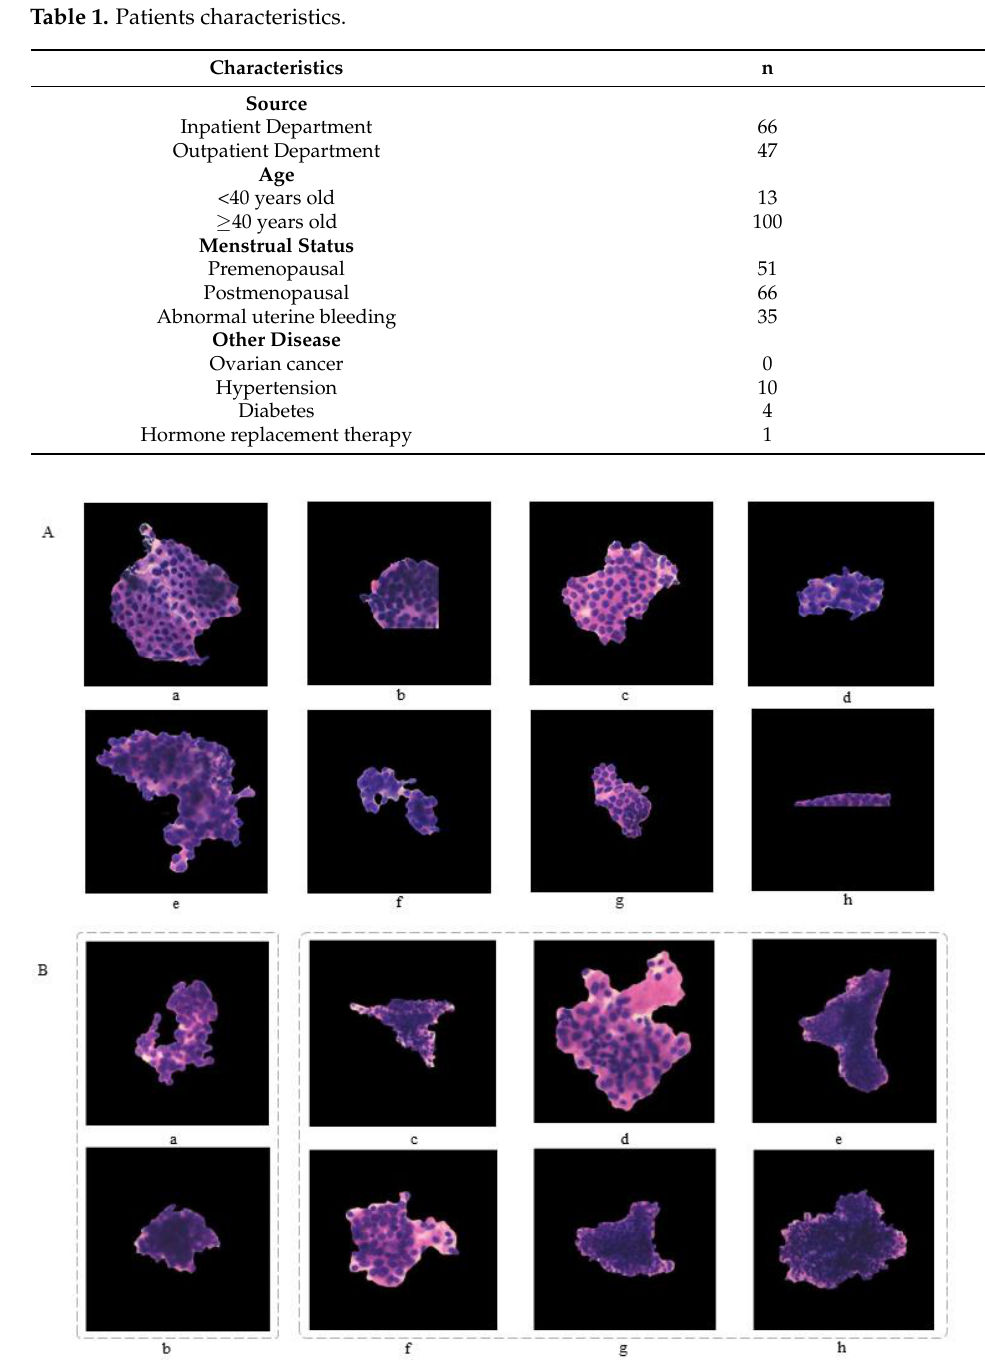
Figure 6. Presentation of true and false results. ( A ) A 100% consistency of results was achieved in the training set. Patches ( a – c ) showed the true positive, and patches ( d – h ) showed the true negative. ( B ) Analysis of false results in test set. The two false-positive (over diagnosis) patches ( a , b ) are exhibited. The six false-negative patches included one well-differentiated endometrial adenocarcinoma ( c ), three atypical hyperplasia ( d – f ), and two poorly differentiated adenocarcinomas ( g , h